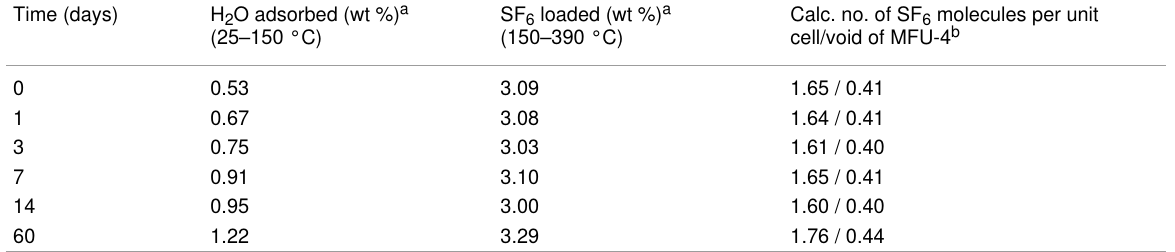
Table 2: SF 6 release from MFU-4 (Sample 3a) stored in air at room temperature for 0–60 days as evaluated by thermogravimetric analysis (Figure 6).